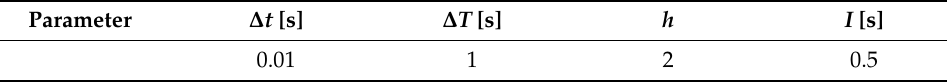
Table 2. Main parameters of the PKME method.